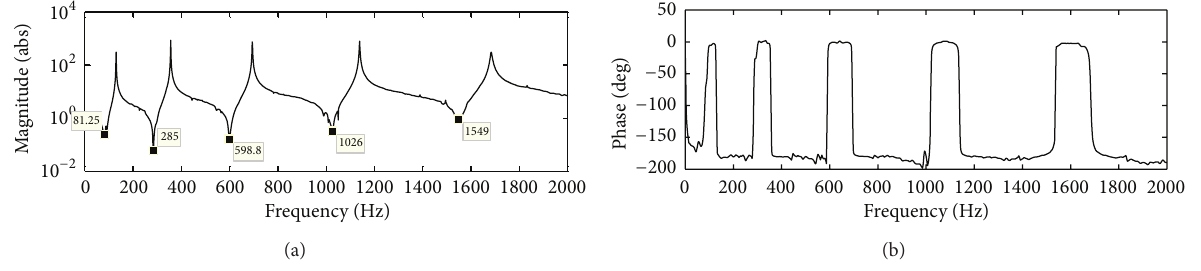
Figure 3: Identification of experimental anti-resonant frequencies.